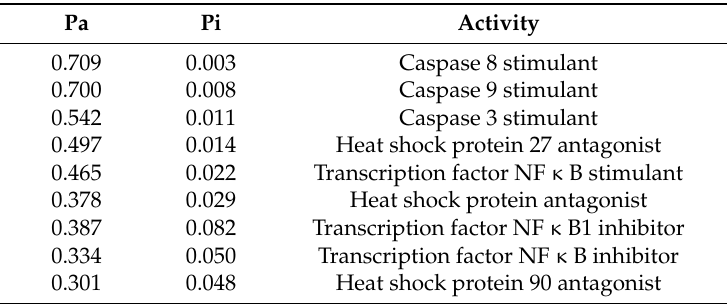
Table 1. Predicted biological activity spectrum for compound